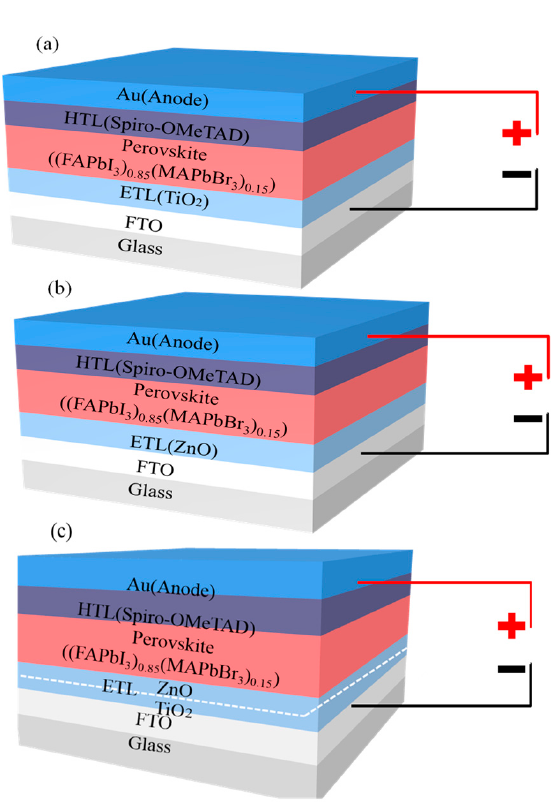
Figure 1. Solar cell structures of different electron transport layers (ETLs): ( a ) solar cell structure of TiO 2 as ETL, ( b ) solar cell structure of ZnO as ETL and ( c ) solar cell structure of TiO 2 /ZnO as ETL.